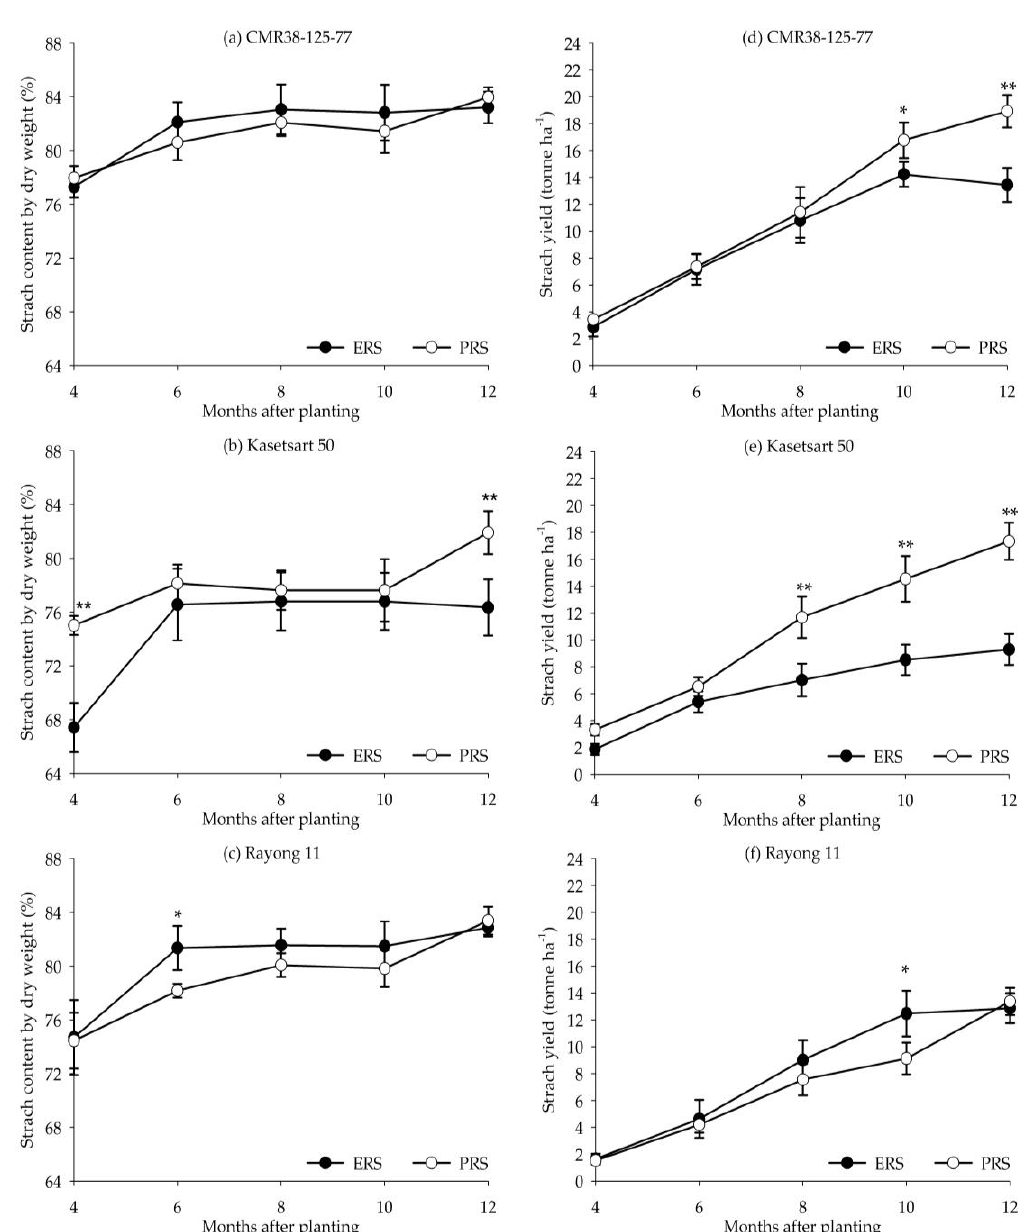
Figure 2. Means of starch content (%) and starch yield (tonne ha −1 ) of three cassava genotypes in early rainy seasons (ERS) and post rainy seasons (PRS). *, ** = significant differences between baseline and the respective time point at p < 0.05 and significant at p < 0.01 level, respectively (LSD test). All data are presented as mean ± standard error of the mean ( n = 8). ( a , d ) = CMR38-125-77, ( b , e ) = Kasetsart 50 and ( c , f ) = Rayong 11.